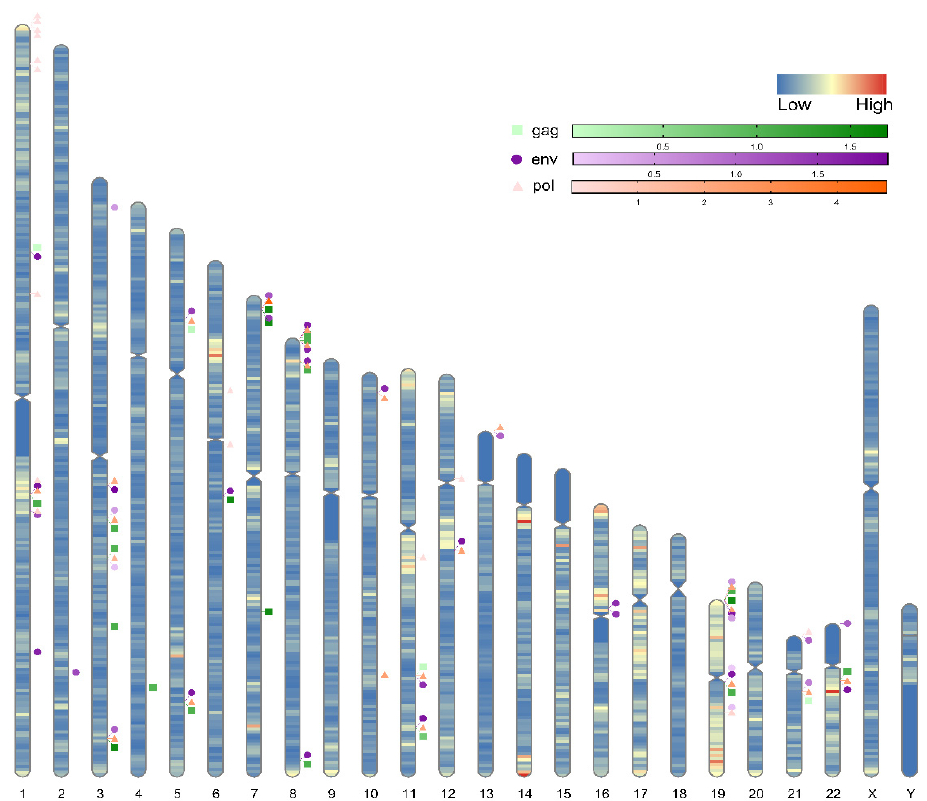
Figure 3. Diagram of the genome-wide distribution of highly expressed HERV-K (HML-2) gag , env , and pol . There are 25 HERV-K (HML-2) gag , 36 env and 37 pol loci in the human genome that are highly expressed. The gag locus is represented by a green square, the env locus is represented by a purple circle, the pol locus is represented by an orange triangle, and the gradual colour represents the relative gene expression at different loci.